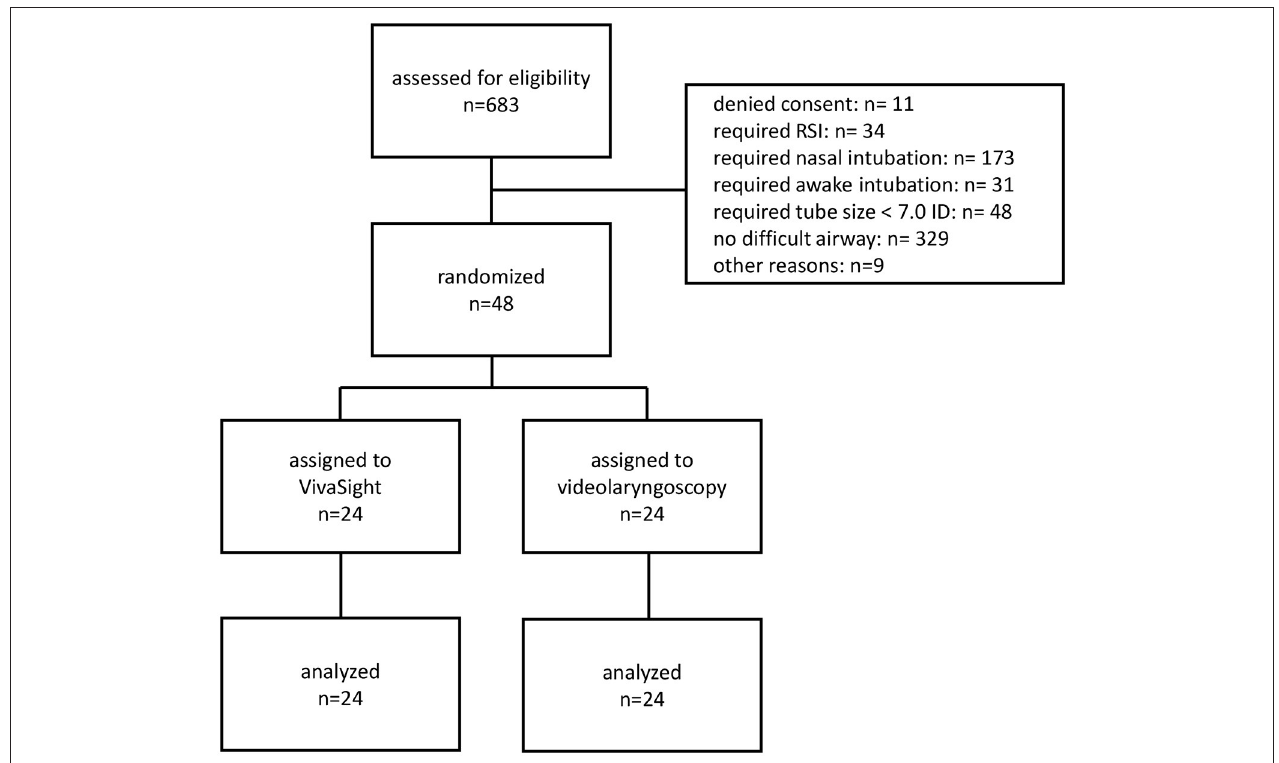
FIGURE 2 | CONSORT diagram. RSI, rapid sequence